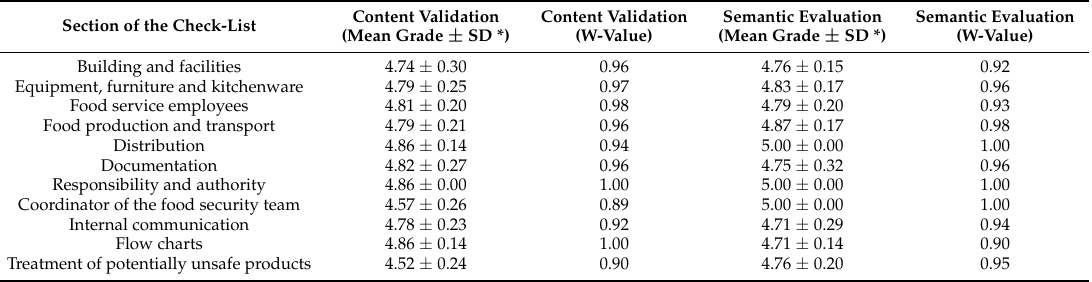
Table 1. Experts evaluation of the check-list—mean grades and Kendall coefficient of concordance of the check-list